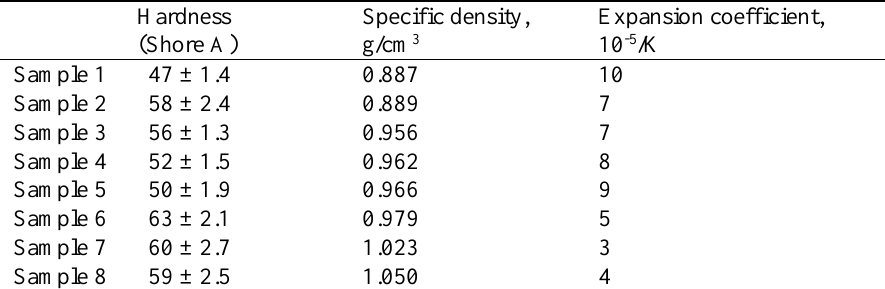
Table 1. Results of hardness and specific density of obtained fire-retardant